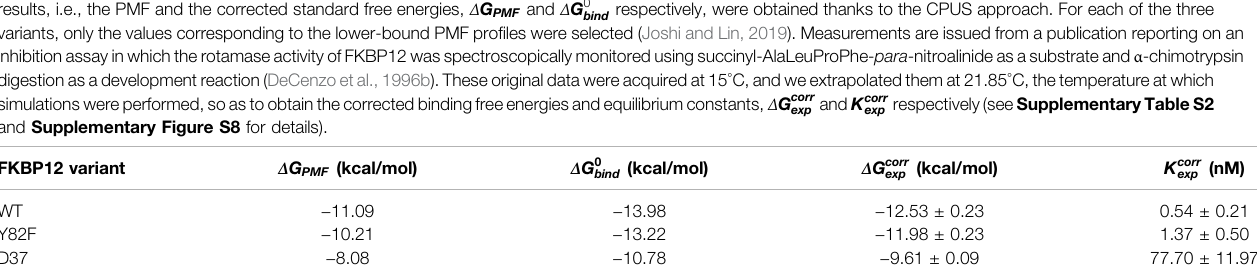
(cid:129) rapamycinreaction.MD